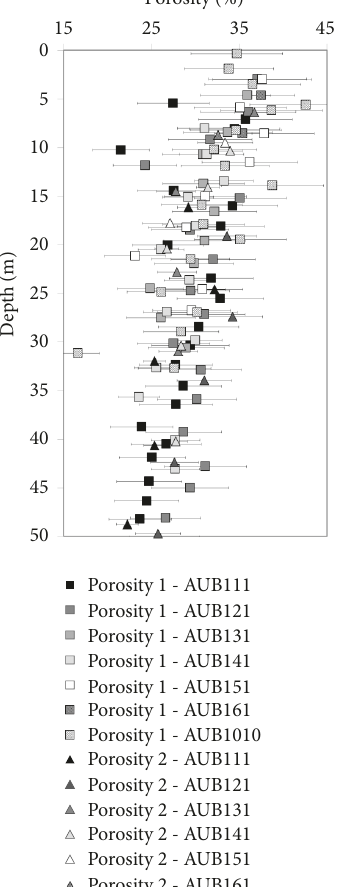
Figure 7: Porosities of the core clay samples from the seven boreholes repositioned on a vertical profile as a function of